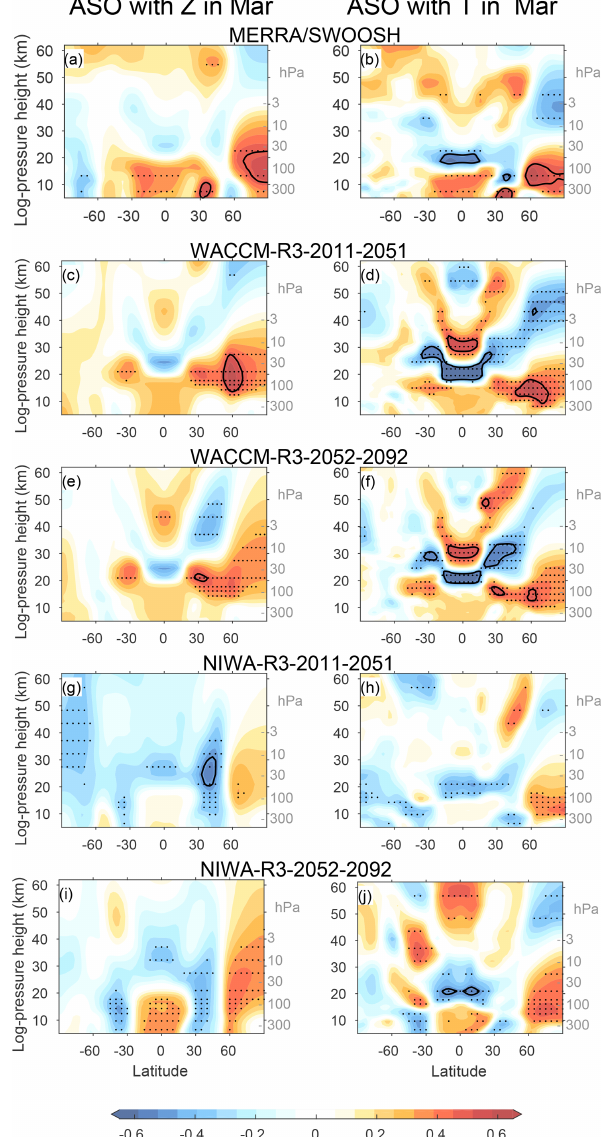
Figure 2. Correlation coefficients between ASO and geopotential height anomalies (a, c, e, g, i) and between ASO and tempera- ture anomalies (b, d, f, h, j) in March for each of the examined data sources: (a–b) MERRA/SWOOSH, (c–f) WACCM-R3, and (g–j) NIWA-R3. The black dots represent locations where corre- lations are statistically significant at the 95% level (see Sect. 2.2). Correlations of ± 0 . 5 are thin black. The contour interval is 0.065.